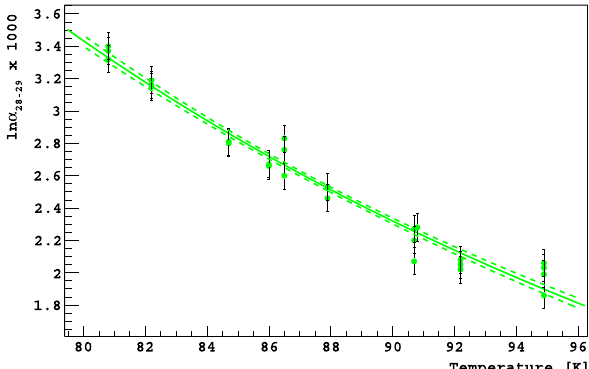
Fig. 22 Dependence of ln α 28 − 29 on temperature. The data points are taken from [25]. A fit with the function y = A · 1 / T 2 + B is overlaid. The continuous line corresponds to the mean value and the dashed lines to the 1 σ ln ˆ α deviation. The errors on the single measurement were set all equal in the fit and determined in retrospect requiring the reduced χ 2 to be 1 In Fig. 22 we report the dependence of ln α 28 − 29 on tem- perature. The data points are taken from [25]. A fit with the function ln α 28 − 29 = A · 1 / T 2 + B is overlaid. Again, the errors on the single measurement were set all equal in the fit and determined in retrospect requiring the reduced χ 2 to be 1. Repeating the same procedure used for argon, at the